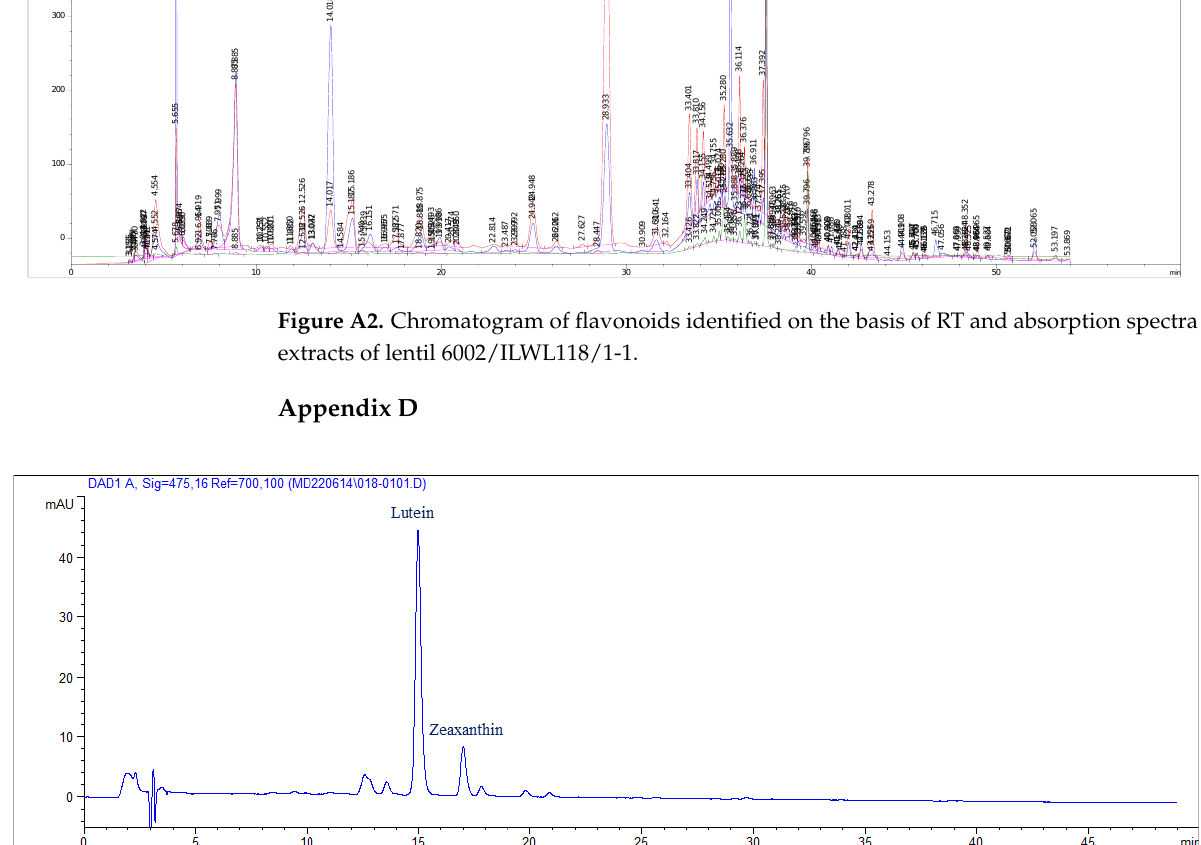
Figure A4. Representative chromatogram of tocochromanols identified on the basis of RT and ab- sorption spectra in the extracts of Svevo, Svevo HA and Faridur. αT3, βT3, αT: α - Tocotrienol, β - Tocotrienol and α -Tocopherol, respectively. Appendix F